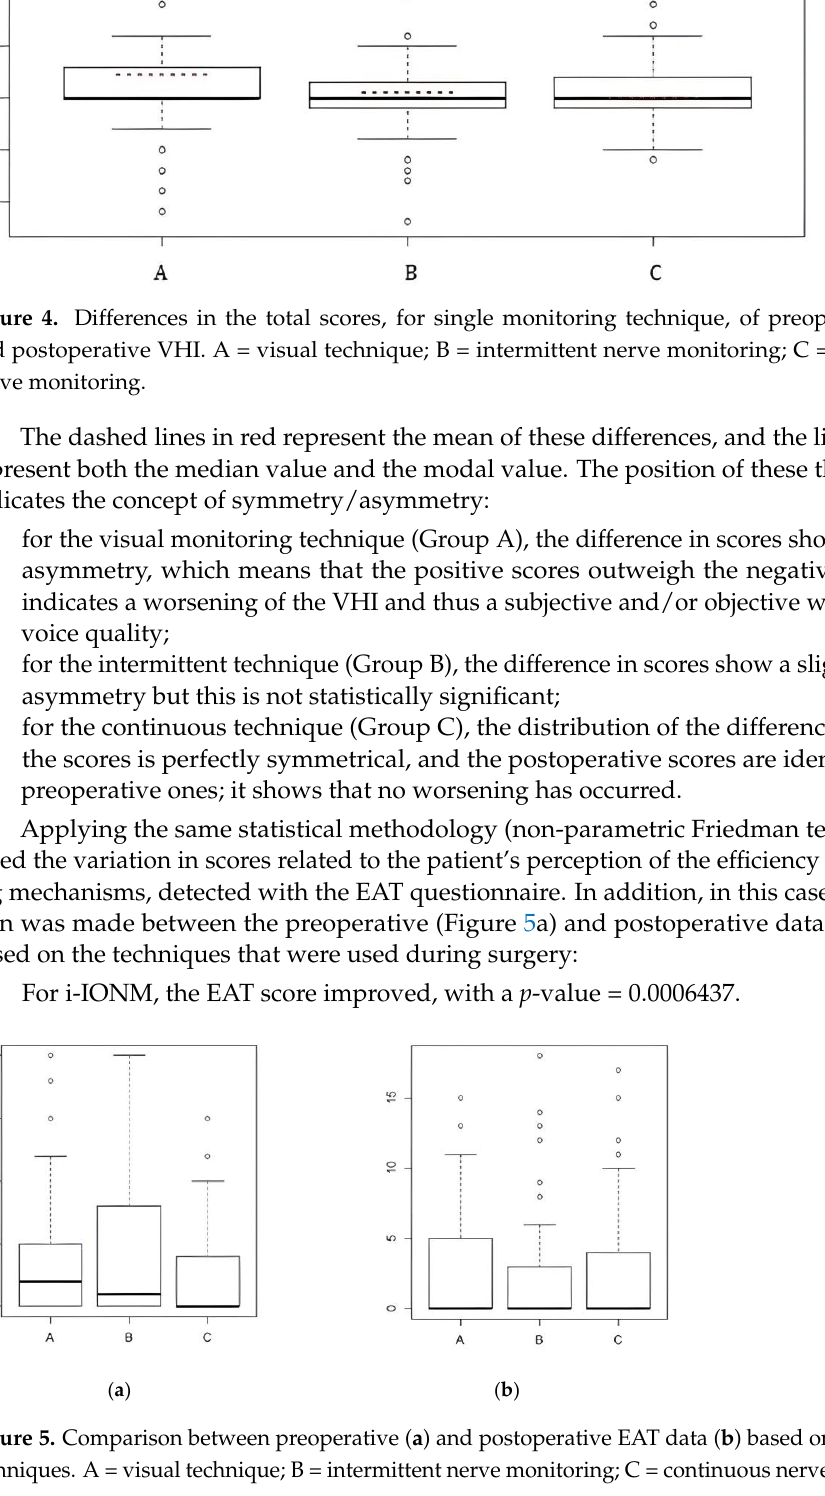
Figure 3. Comparison between preoperative ( a ) and postoperative VHI data ( b ) based on moni- toring techniques. A = visual technique; B = intermittent nerve monitoring; C = continuous nerve monitoring.